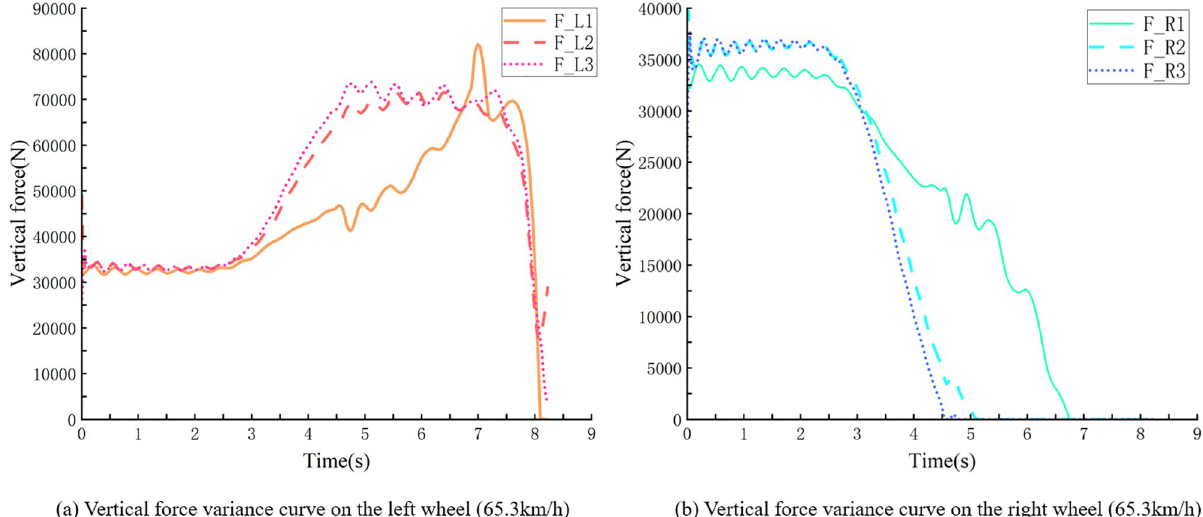
Fig 8. Vertical force curve of vehicle’s left and right wheels bending (65.3 km / h